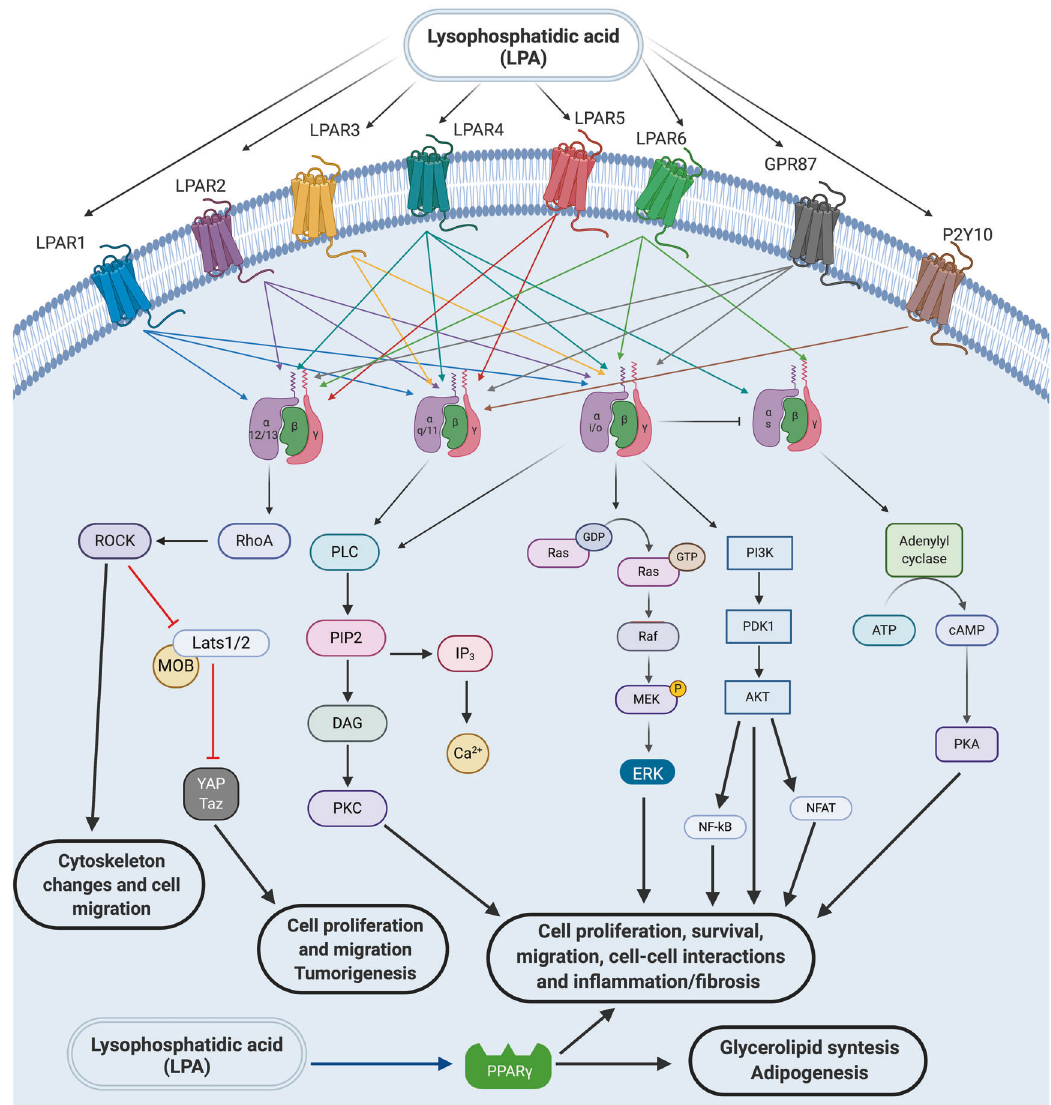
Fig. 2 LPA receptors and signaling intermediates. LPA signals through six different LPA transmembrane G protein-coupled receptors (GPCRs and LPAR1 – 6) and other GPCRs (such as P2Y10 and GRP87). These receptors activate different intracellular signaling mediators to elicit different/several cellular responses (such as cytoskeleton reorganization, migration, proliferation, survival, and cell – cell communication). Finally, LPA was also recently described as a direct PPAR γ agonist and in this sense intracellular LPA could also induce signaling through this receptor. Scheme created using